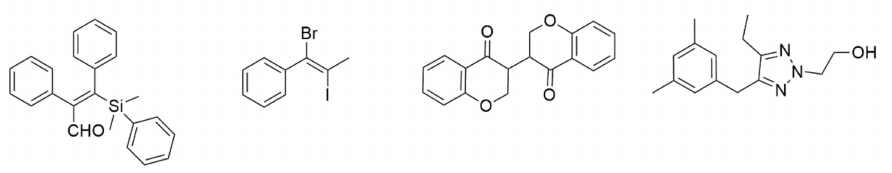
Figure 2. Selected examples of chemicals that were prepared through transformation of a carbon- carbon triple